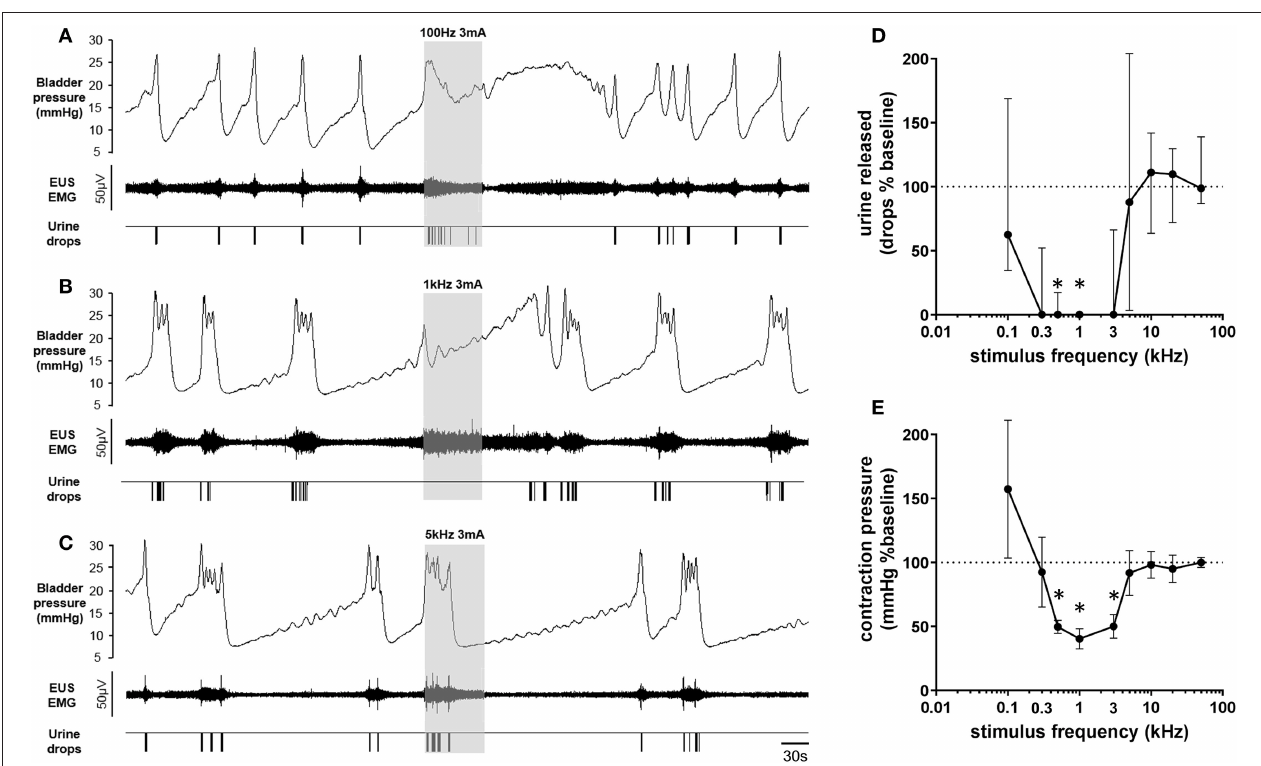
FIGURE 4 | (A–C) Frequency dependent effect of 1 min pelvic nerve stimulation on urinary voiding evoked by continuous infusion of saline into the bladder. All data from the same animal. (D) Amount of urine released, as a percentage of baseline (mean of 3 previous voids) during the first 30s of pelvic nerve stimulation at different stimulation frequencies ( n = 6). Data displayed as median ± interquartile range; * p < 0.05, Wilcoxon signed rank test, n = 6. (E) Maximum rise in pressure above void threshold during pelvic nerve stimulation expressed as a percentage of baseline void pressure (baseline: mean of 3 previous voids). Data are displayed as mean